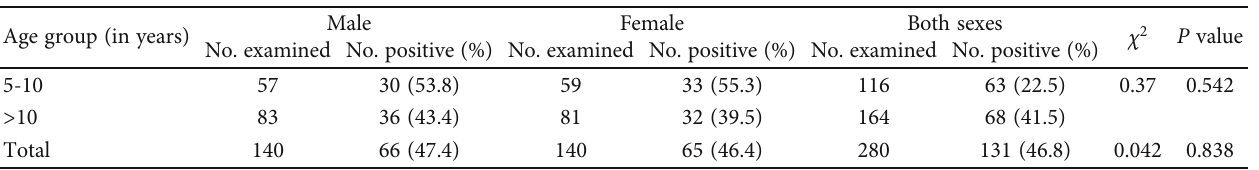
Table 2: Prevalence of intestinal protozoan parasitic infections by age and sex among school children in Merhabete district, Amhara region, Central Ethiopia, 2020 ( N = 280 ).